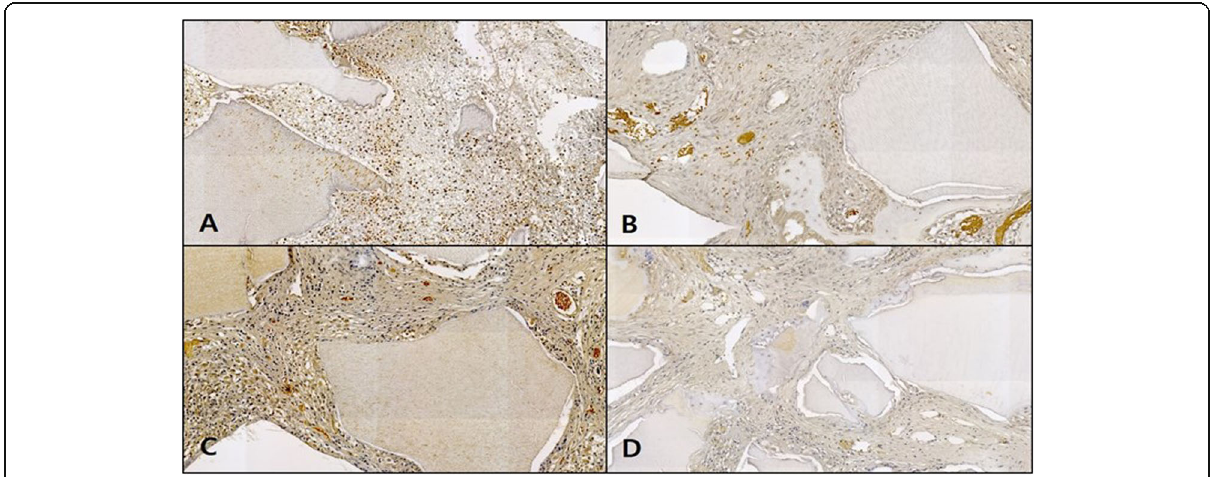
Fig. 14 Microphotograph at 1 week ( A ), 2 weeks ( B ), 4 weeks ( C ), and 6 weeks (D) after bone graft with organic matter removed particulate autogenous tooth in experimental rabbit. Osteocalcin.